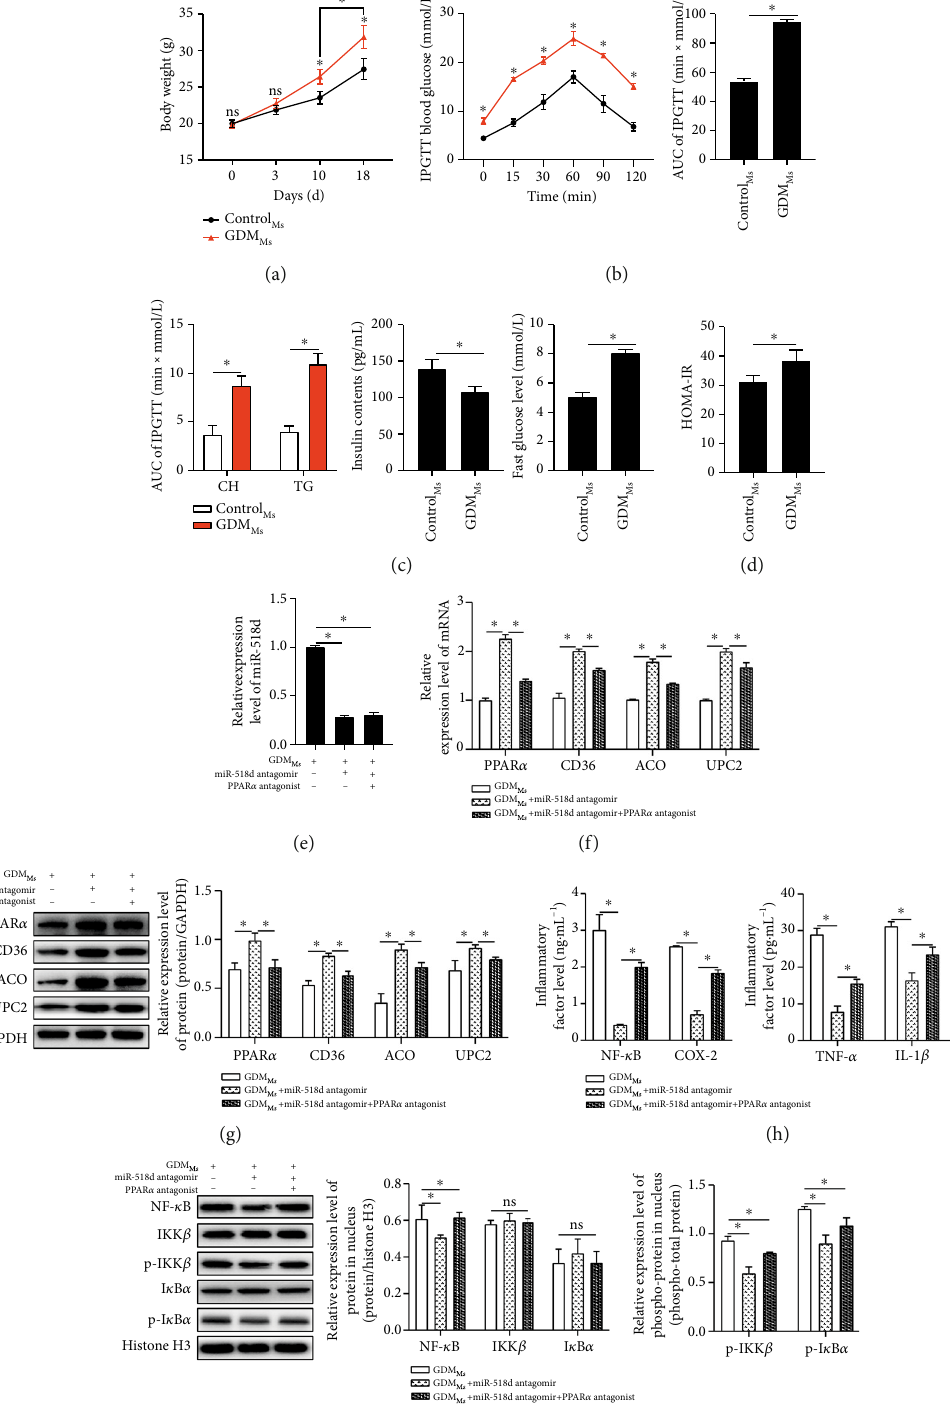
Figure 5: Regulation of miR-518d through the PPAR α -mediated NF- κ B pathway in GDM mice. (a) Body weights of mice in both Control and GDM groups recorded on the 0, 3, 10, and 18 days after pregnancy. (b) IPGTT on the 18 th day of pregnancy after 16-hour fasting. (c) Ms Pathological indicator (CH, TG, FBG, and INS) tests on the 18 th day of pregnancy after 12-hour fasting. (d) HOMA-IR calculated based on the data obtained from pathological tests. (e) Expression of miR-518d after transfection. Expression levels of mRNA and proteins of PPAR α and its downstream genes detected by (f) RT-PCT and (g) Western blotting, respectively. (h) Contents of relative in fl ammatory factors (NF- κ B, TNF- α , IL-1 β , IL-6, and COX-2) in peripheral plasma examined by ELISA. (i) Relative expressions in the nucleus of NF- κ B and pathway-related proteins detected by Western blotting. All data were represented as mean ± SD . ∗ p < 0 : 05 , ns p > 0 : 05